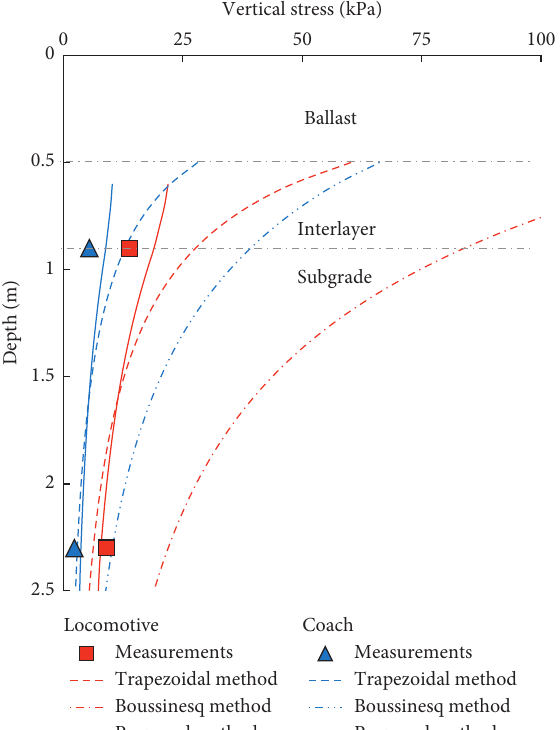
Figure 6: Stress distribution over depth calculations versus measurement at speed 200km/h for the Orleans-Montauban railway.